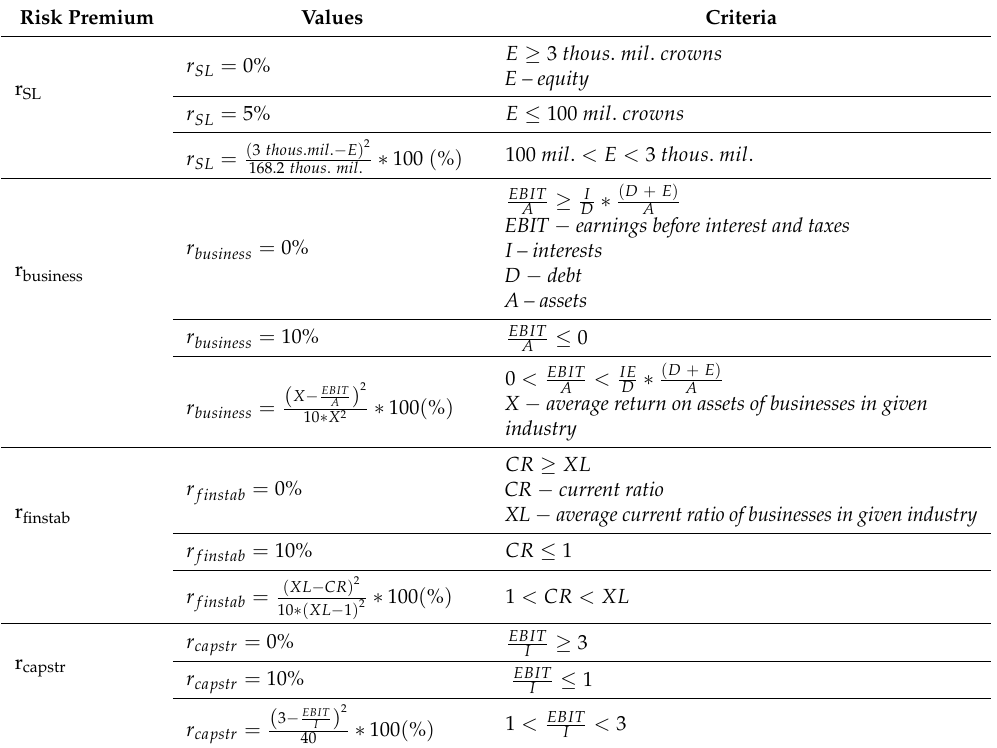
Table 2. Conditions for hotel internal risks